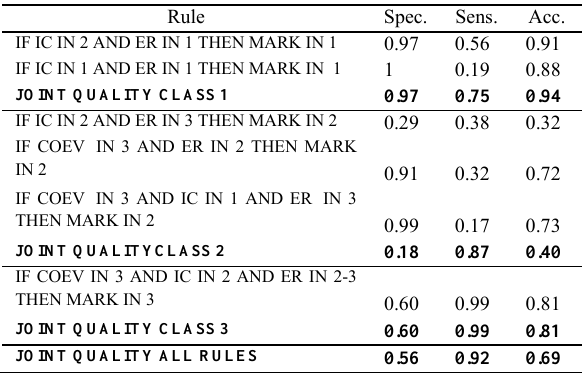
Table 9. Lingustic rules FIR model and its metrics (fuzzification parameters defined by